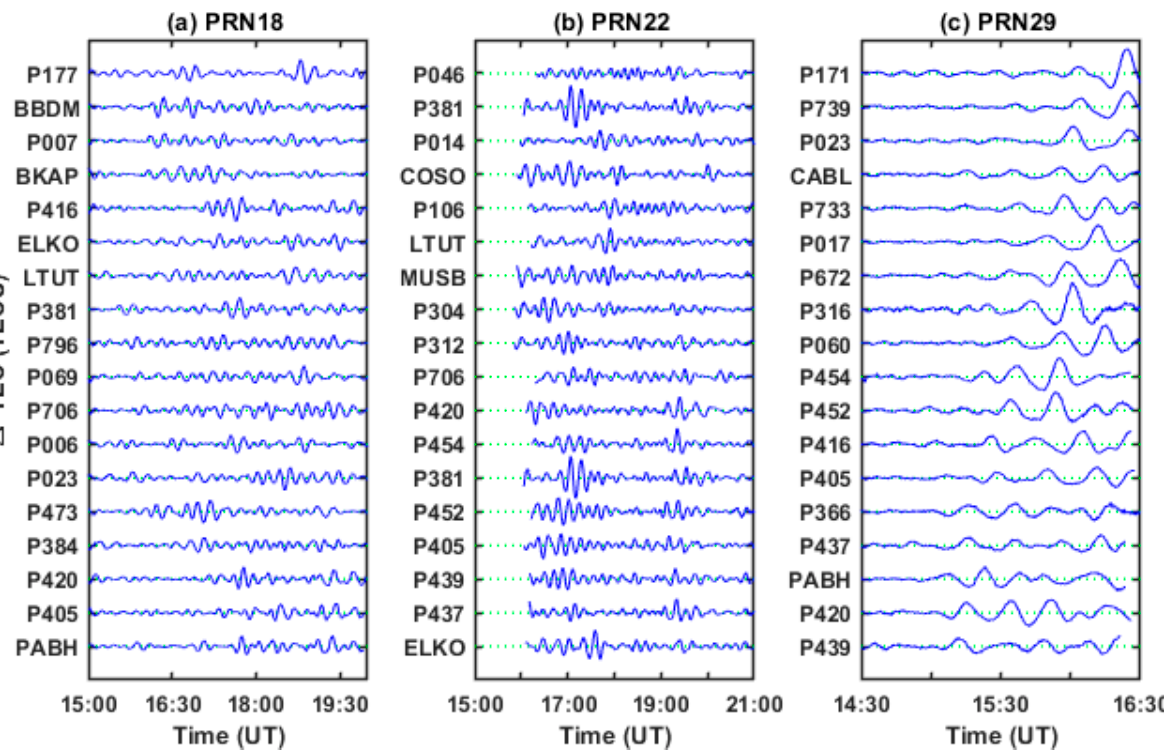
Figure 6. ∆ 2 TEC time series of PRN 18, PRN22, and PRN29 observed from different GPS stations between 14:30 UT and 21:00 UT on 11 March (the day of the tsunami). Results from each station are vertically shifted from the previous station by two TECU in ( a ) and ( b ), and results from each station are vertically shifted from the previous station by one TECU in ( c ).